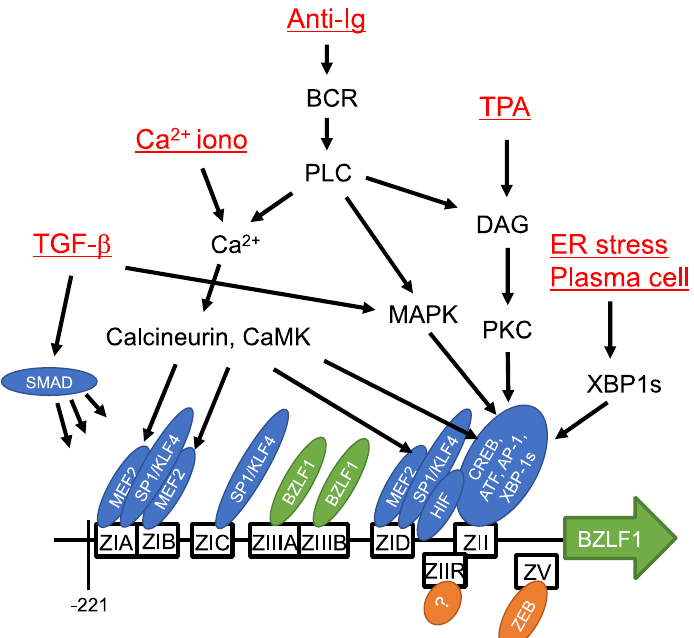
Figure 3. Cis - and trans -acting elements of BZLF1 promoter and signaling pathways. Cis -acting elements of the BZLF1 promoter sequence sufficient for induction in response to lytic stimuli are depicted as boxes. Transcription factors that bind the elements are indicated by ellipses. Inducing reagents/stimuli and signaling molecules are also shown. Modified from [54].